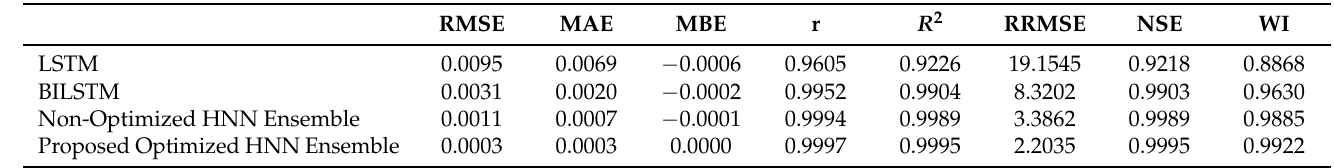
Table 8. Evaluation of the prediction results achieved by the proposed optimized stacked ensemble model applied to the wind speed dataset.